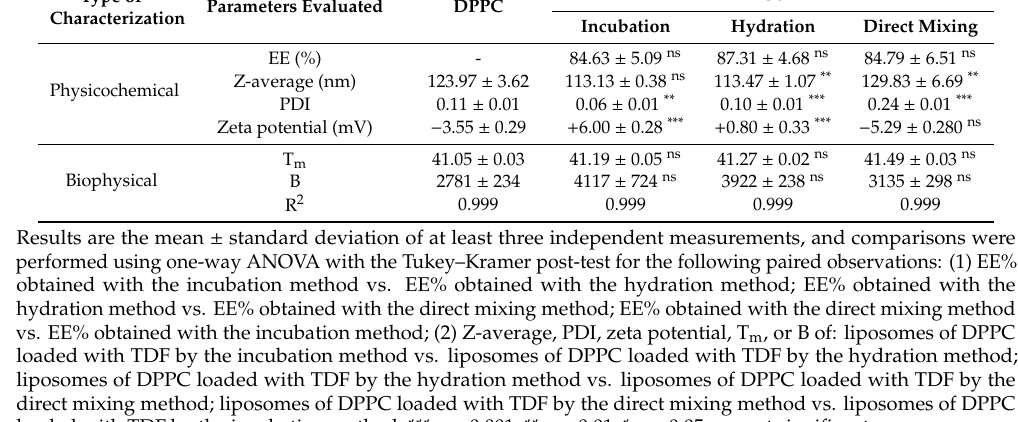
Table 4. Physicochemical and biophysical characterization of empty DPPC liposomes and DPPC liposomes loaded with TDF by di ff erent methods (incubation, hydration, and direct mixing), including: Encapsulation e ffi ciency (EE%), mean hydrodynamic diameter (Z-average), polydispersity index (PDI), zeta potential, main phase transition temperature (T m ), and cooperativity of the phase transition (B). R 2 is the coe ffi cient of determination of T m and B after fitting data with Equation (1). DPPC + TDF Type of Parameters Evaluated DPPC Characterization Incubation Hydration Direct Mixing Physicochemical